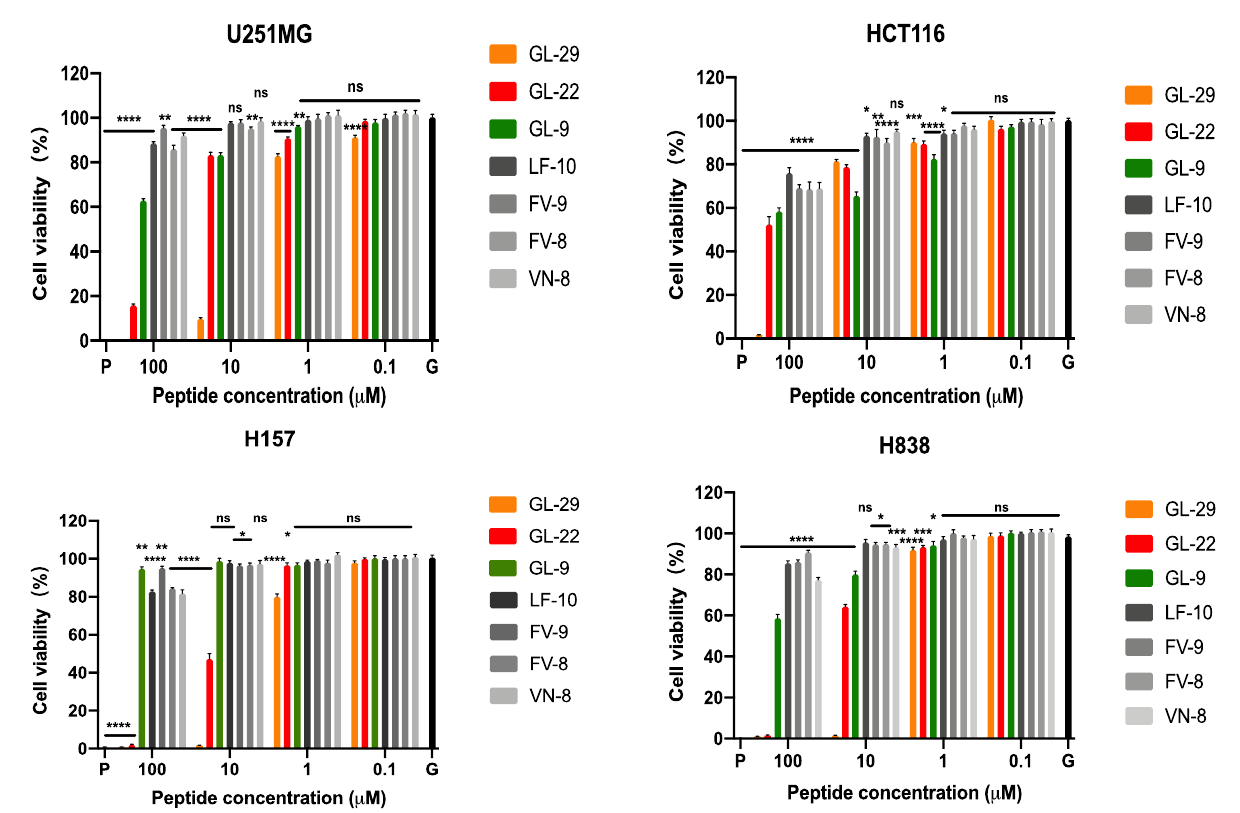
Figure 6. The effects of GL-29 and its analogues on the proliferation of the human malignant glioblastoma astrocytoma cell line, U251MG, human colon cancer cell line, HCT116, human non-small lung cancer cell line, H157 and H838. P and G represent the positive control (cell growth with 0.1% TritonX-100) and growth control (cell growth without peptides), respectively. The percentage of cell viability was calculated by comparison with the growth control group. The error bars represent SEM of nine repeats from three independent tests. The statistical significance was analysed using two- way ANOVA by comparison with the growth control group and is indicated as ns (non-significant difference), * ( p < 0.05), ** ( p < 0.01), *** ( p < 0.001), **** ( p < 0.0001). Table 4. The IC 50 values of GL-29 and GL-22 against different cell lines.